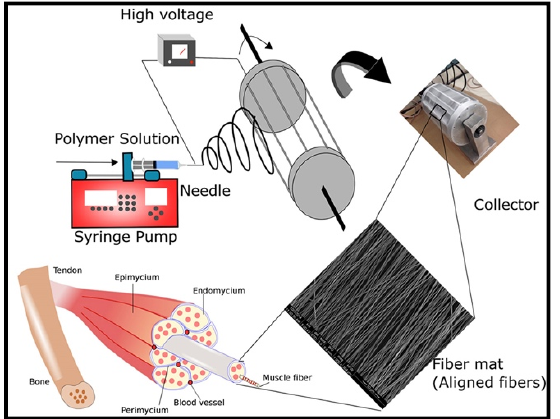
Figure 5. Schematic illustration of electrospun scaffold fabrication for tissue muscle regeneration via electrospinning technique [79]. Copyright © 2020 Frontiers Media SA.